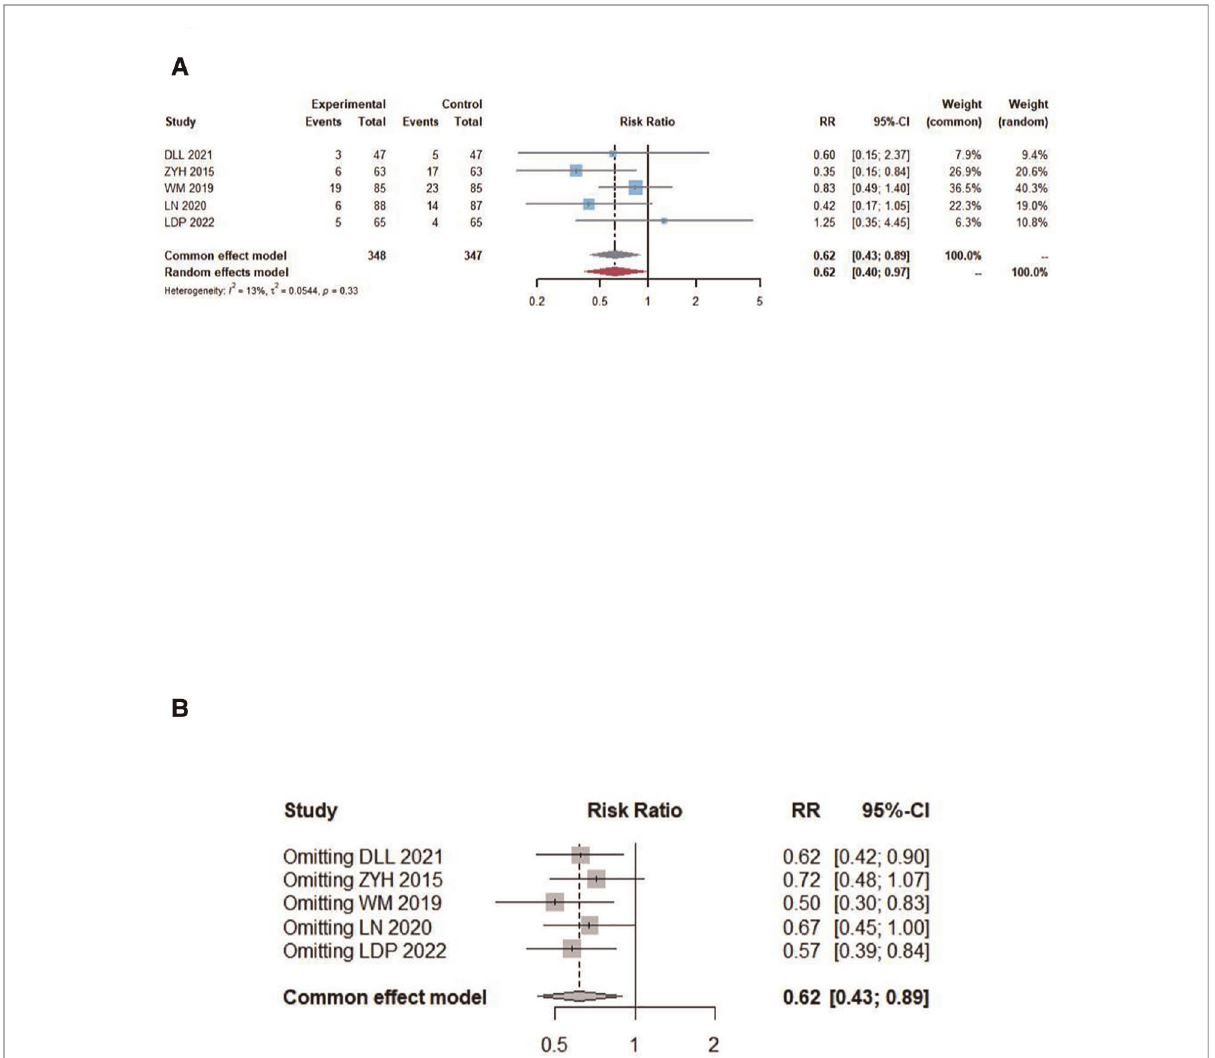
FIGURE 4 Overall meta-analysis forest and sensitivity analysis plot of adverse effects rates. ( A ) Overall meta-analysis forest plot, there were no signi fi cant statistically signi fi cant differences ( I 2 =12.4%, P =0.3316); thus, the fi xed model was assumed. The combination of DNG with TCM for endometriosis can signi fi cantly reduce the rate of adverse reactions compared to DNG or TCM alone (RR=0.6177; 95% CI, 0.4288, 0.8899; P = 0.0097). ( B ) sensitivity analysis plot of the adverse effects rates, according to the leave-one-out method sensitivity analysis, the individual study results had no impact on the meta-analysis